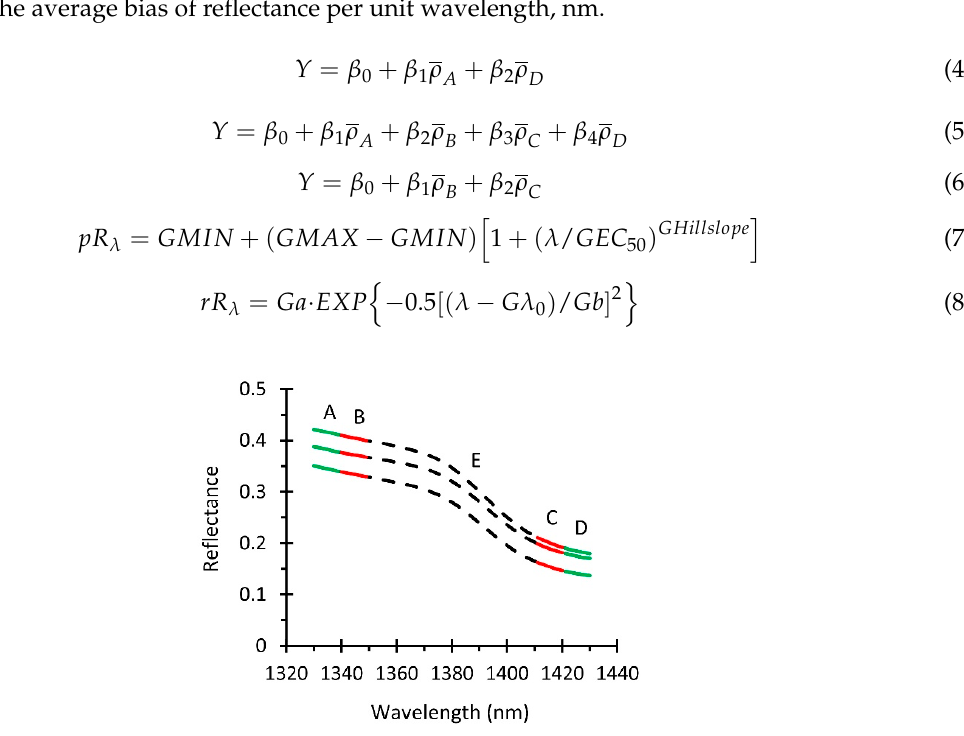
Figure 3. A diagram of SWIR spectral segmentation parameterizing a generalized Logistic-Gaussian complex signal model. The dashed line between the B and C bases depicts the central segment E to be restored. A and D are signal bases which will be used to estimate the MIN and MAX, additionally the EC50 and Hillslope are determined using all signal bases A–D. Gaussian parameters are derived using B and C.